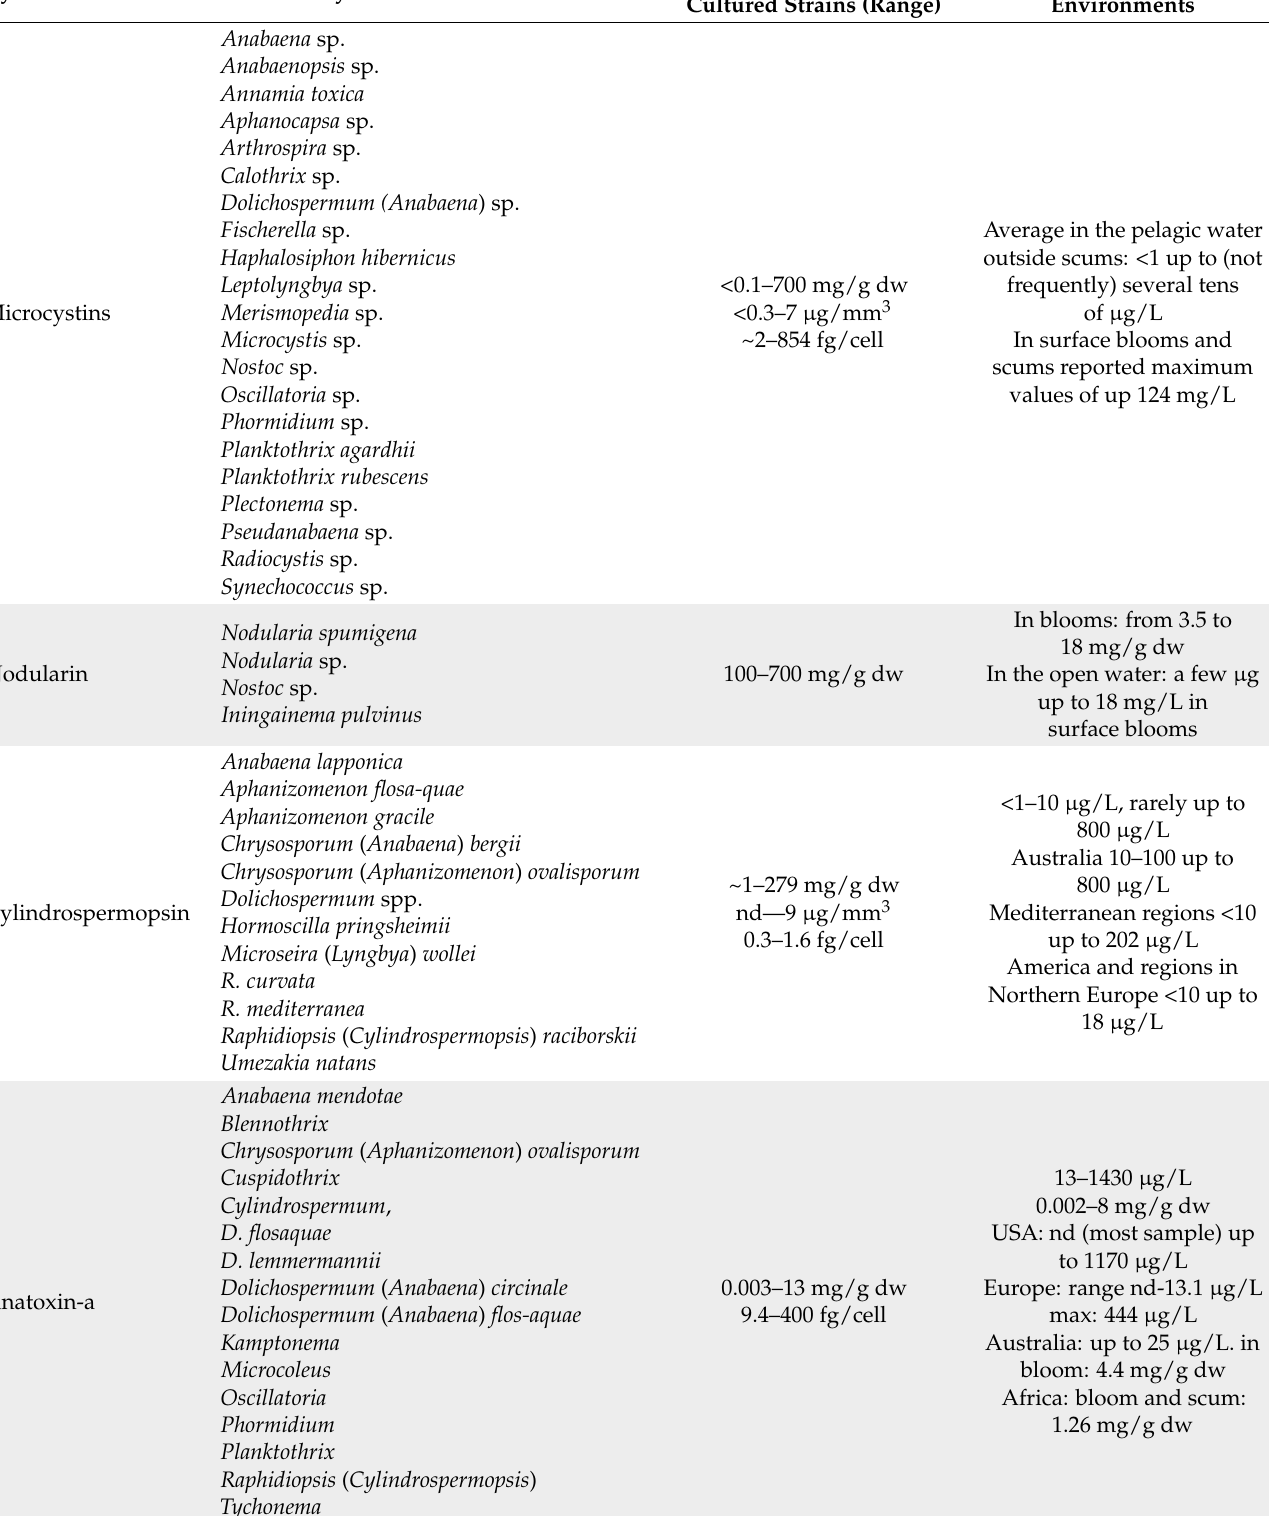
Table 1. Cyanotoxins and their cyanobacterial sources—summary of intracellular concentrations in cultured strains and occurrence in the environment. Cyanotoxins Contents in Occurrence in Water Cultured Strains (Range)